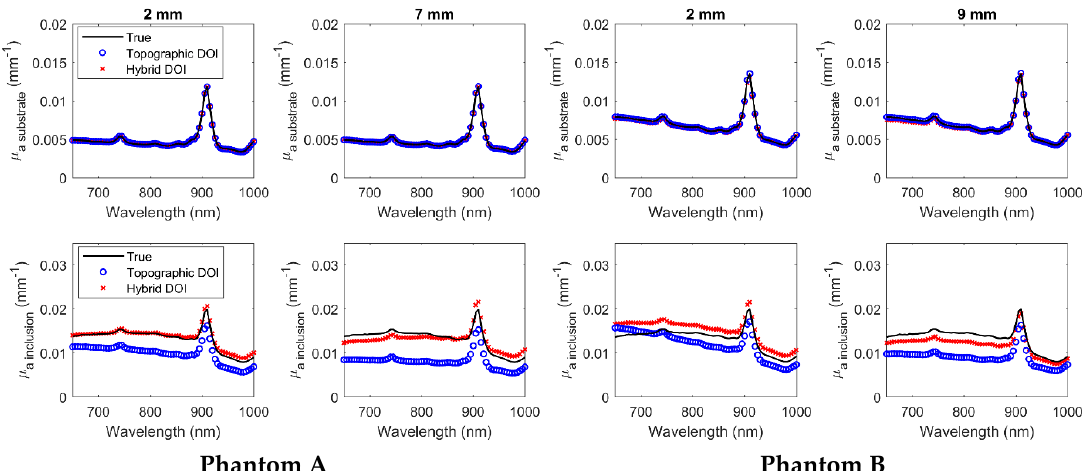
Figure 11. Hyperspectral substrate (row 1) and inclusion µ a (row 2) at wavelengths 650 nm to 1000 nm for phantoms A and B.